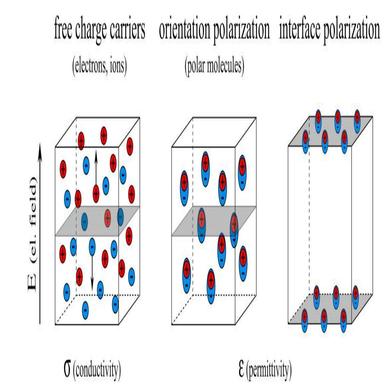
Structure of a carbon black network with a fractal filler cluster of size ξ. Virgin filler agglomerate is presented on the left. The circles represent primary carbon black aggregates. In the middle, conductive paths within the carbon black network are shown in green. On the right, paths that are defective due to mechanical loading are shown in red. (For interpretation of the references to colour in this figure legend, the reader is referred to the Web version of this article.)